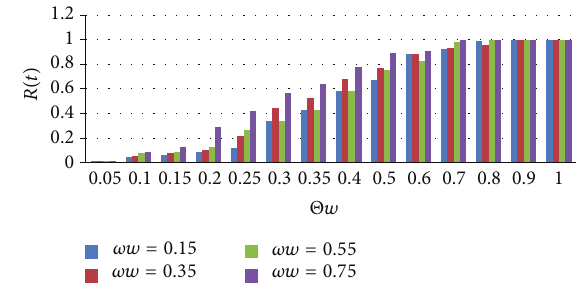
Figure 8: Immune probability influenced on the density of removed